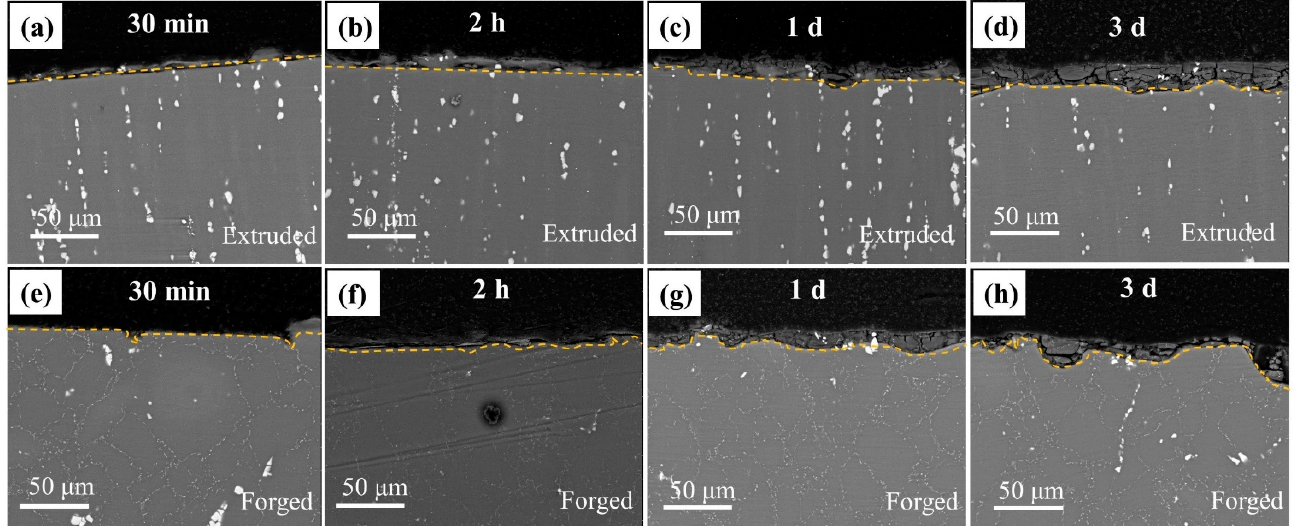
Figure 6. Surface morphologies of the ( a – d ) extruded and ( e – h ) forged WE43 alloys after immersion in 0.6 M NaCl solution for ( a , e ) 30 min, ( b , f ) 2 h, ( c , g ) 1 day, and ( d , h ) 3 days.